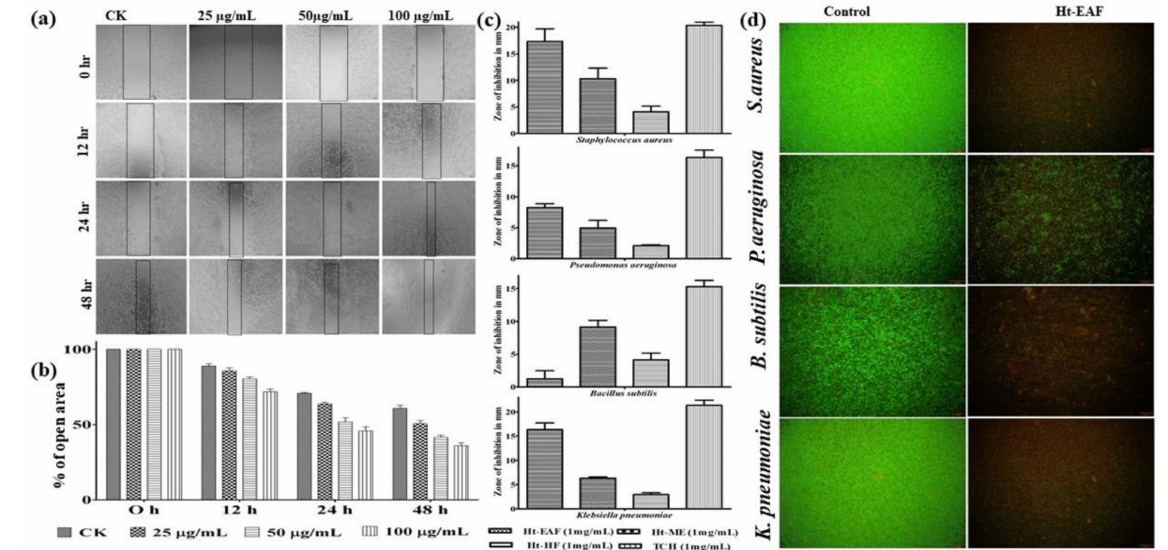
Figure 4. ( a , b ) Cell migration activity of different concentrations of Ht-EAF-treated NIH3T3 cells. ( c ) Zone of inhibition of Ht-EAF treated with different bacterial stains. ( d ) Live/Dead TM BacLight TM bacterial viability assay. Data were expressed as mean ± standard deviation of three independent